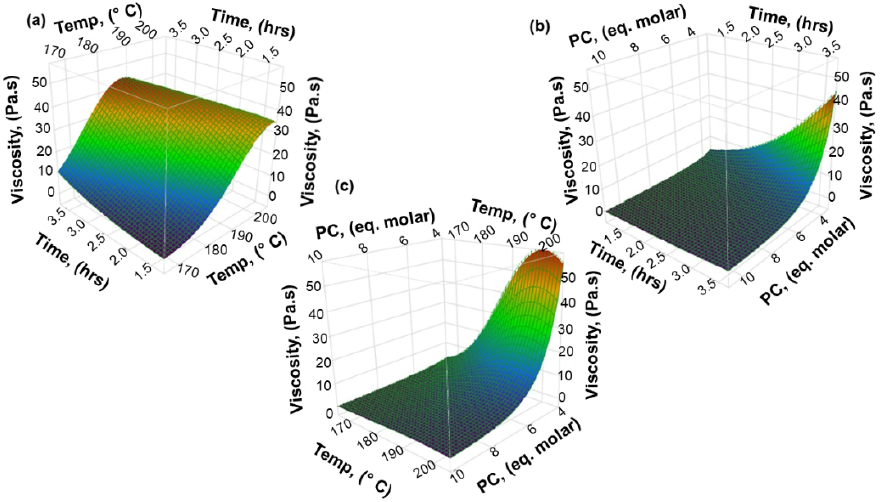
Figure 9. Three-dimensional surface plots for the viscosity of lignin-based polyol: ( a ) The interaction Temp. andTime effect on the viscosity, ( b ) The interaction effect Time and PC on the viscosity, ( c ) The interaction effect Temp. and PC on the viscosity.